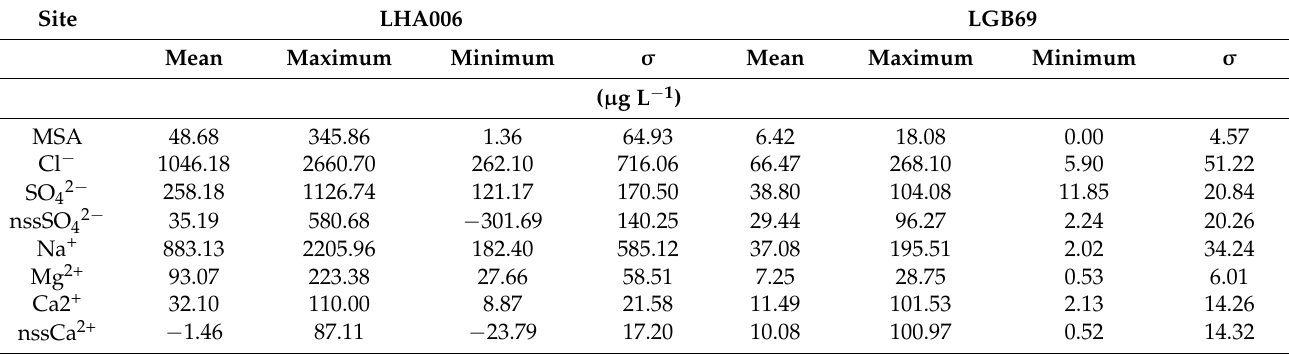
The spatial distributions of sea-salt ions in the two snow pits were also analyzed. The concentrations of Cl − , Na + , and Mg 2+ of the LHA006 snow pit ranged from 262.10 to 2660.70, 182.40 to 2205.96, and 27.66 to 223.38 µ g L − 1 , respectively, whereas those of the LGB69 snow pit ranged from 5.90 to 268.10, 2.02 to 195.51, and 0.53 to 28.75 µ g L − 1 , respectively (Table 6). Given that LHA006 is located in the steep coastal escarpment region, the mean concentrations of these three sea-salt ions were considerably higher at LHA006 than at LGB69, which can be attributed to the preferential wet or dry deposition of sea- salt aerosols. Table 6. Mean, maximum, minimum, and standard deviation ( σ ) of major ion concentrations in the LHA006 and LGB69 snow pits.